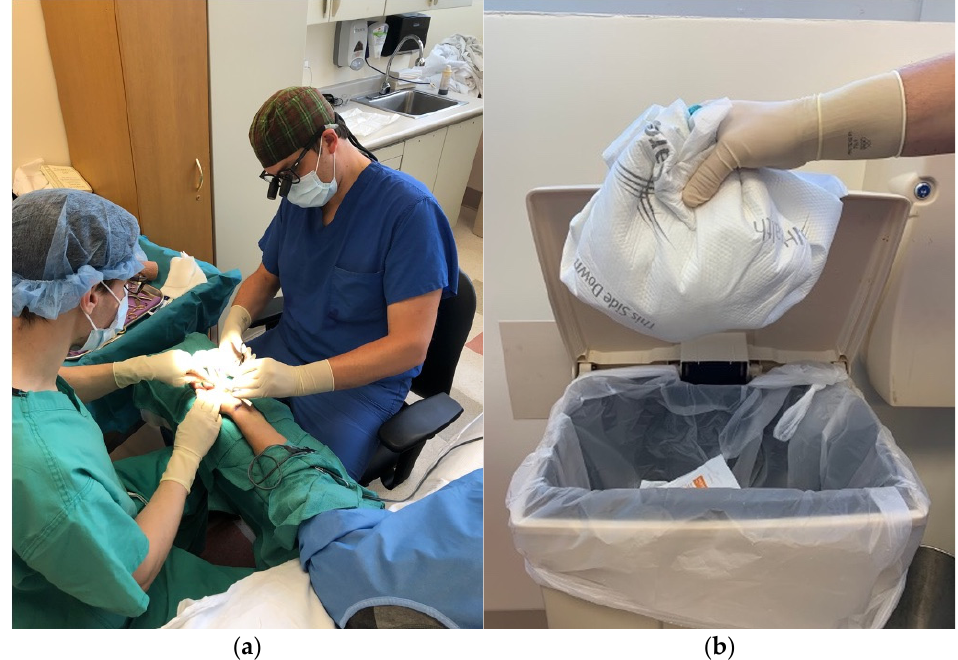
Figure 1. ( a ) Intraoperative set-up. Main surgical attending ( right ) is accompanied by a resident surgeon ( left ) during CTR under WALANT using field sterility. ( b ) Collection of all disposable materials from one CTR procedure.